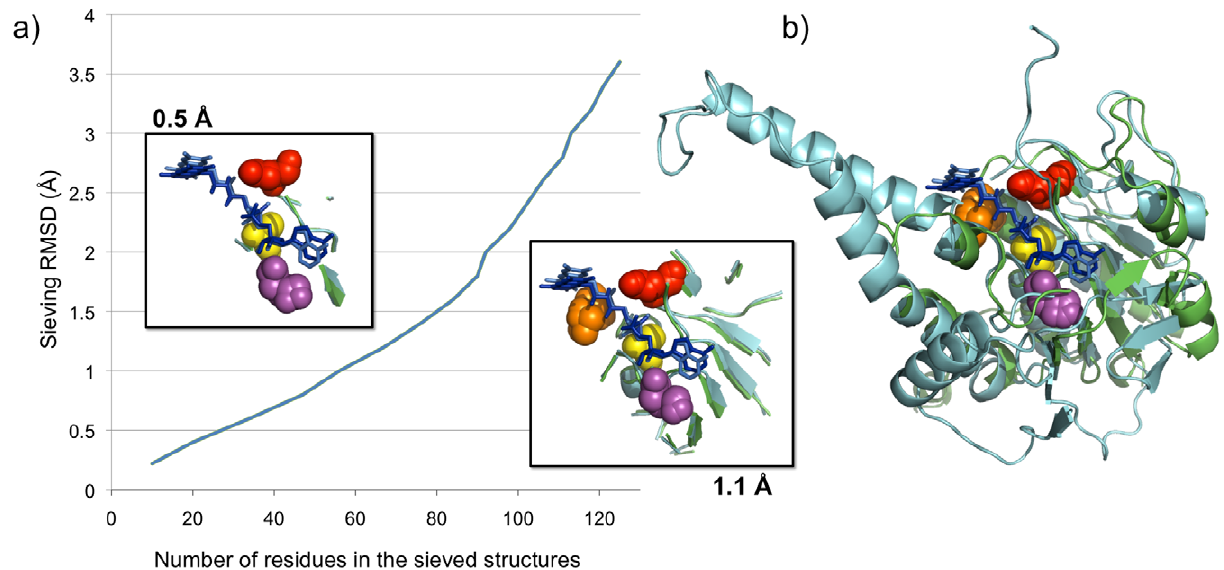
Figure 5. Lesk-Hubbard plot and aligned structures of d1gt8a4 and d1mo9a1. A) Plot of number of residue correspondences vs. RMSD in each structure (d1gt8a4 is in green, d1mo9a1 in cyan). Both domains exhibit an identical curve. The boxes highlight superpositions of sieved structures with their corresponding RMSD. Van der Waals representations of residues are, for d1gt8a4 and d1mo9a1 respectively: D481/D353 in red, A198/A54 in yellow, E128/E73 in magenta and T489/M361 in orange. FAD molecules are represented as sticks in dark blue (d1gt8a4) and pale blue (d1mo9a1); B) Structural alignment of the domains with bound FAD as generated by MUSTANG.